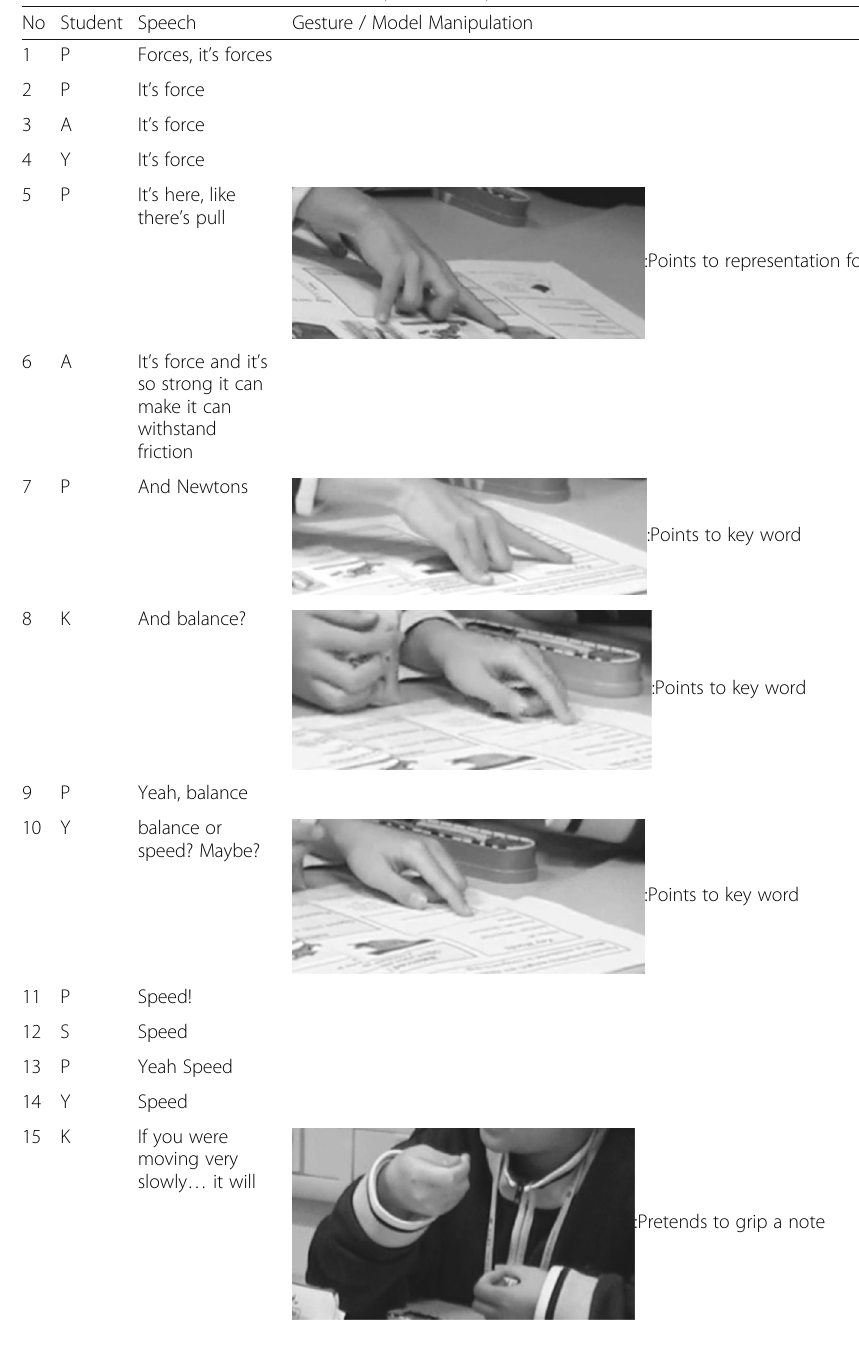
Table 1 Identification of Science Concepts in Group